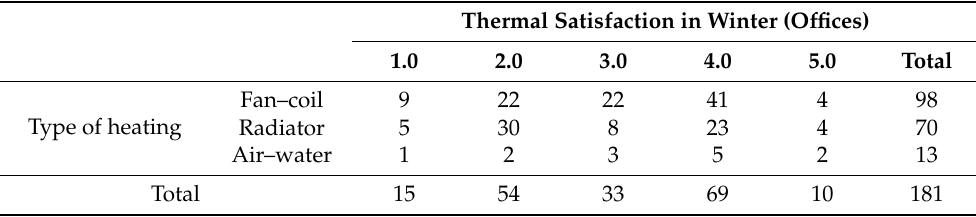
Table 8. Contingence table for Thermal satisfaction in winter (offices) and type of